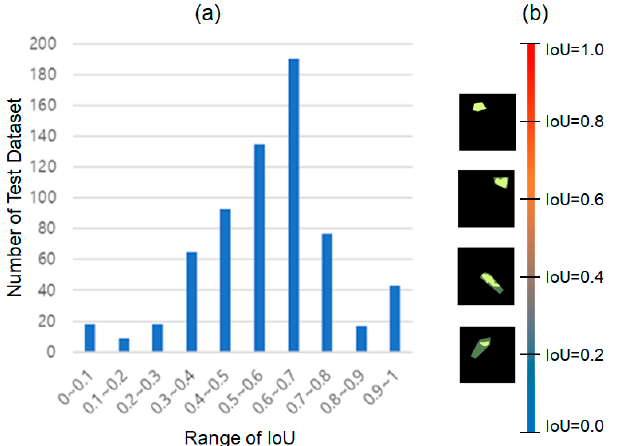
Figure 6. Number of test datasets (vertical axis) corresponding to the IoU range (horizontal axis) calculated by comparing human-segmented and DNN-predicted binary mask images for test datasets. ( a ) Number of test dataset corresponding to the IoU range calculated from prediction, ( b ) Comparison between target masking and predicted masking according to IoU value